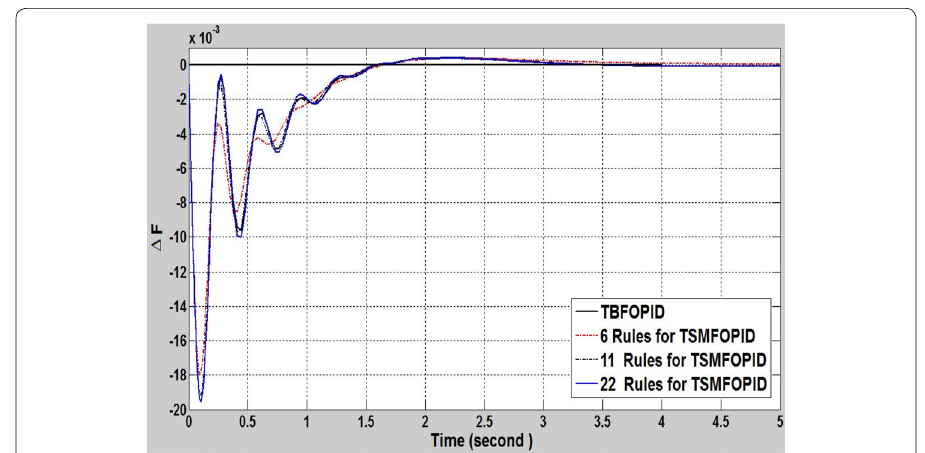
Fig. 11 Dynamic responses of ∆F controlled by TBFOPID and TSMFOPID